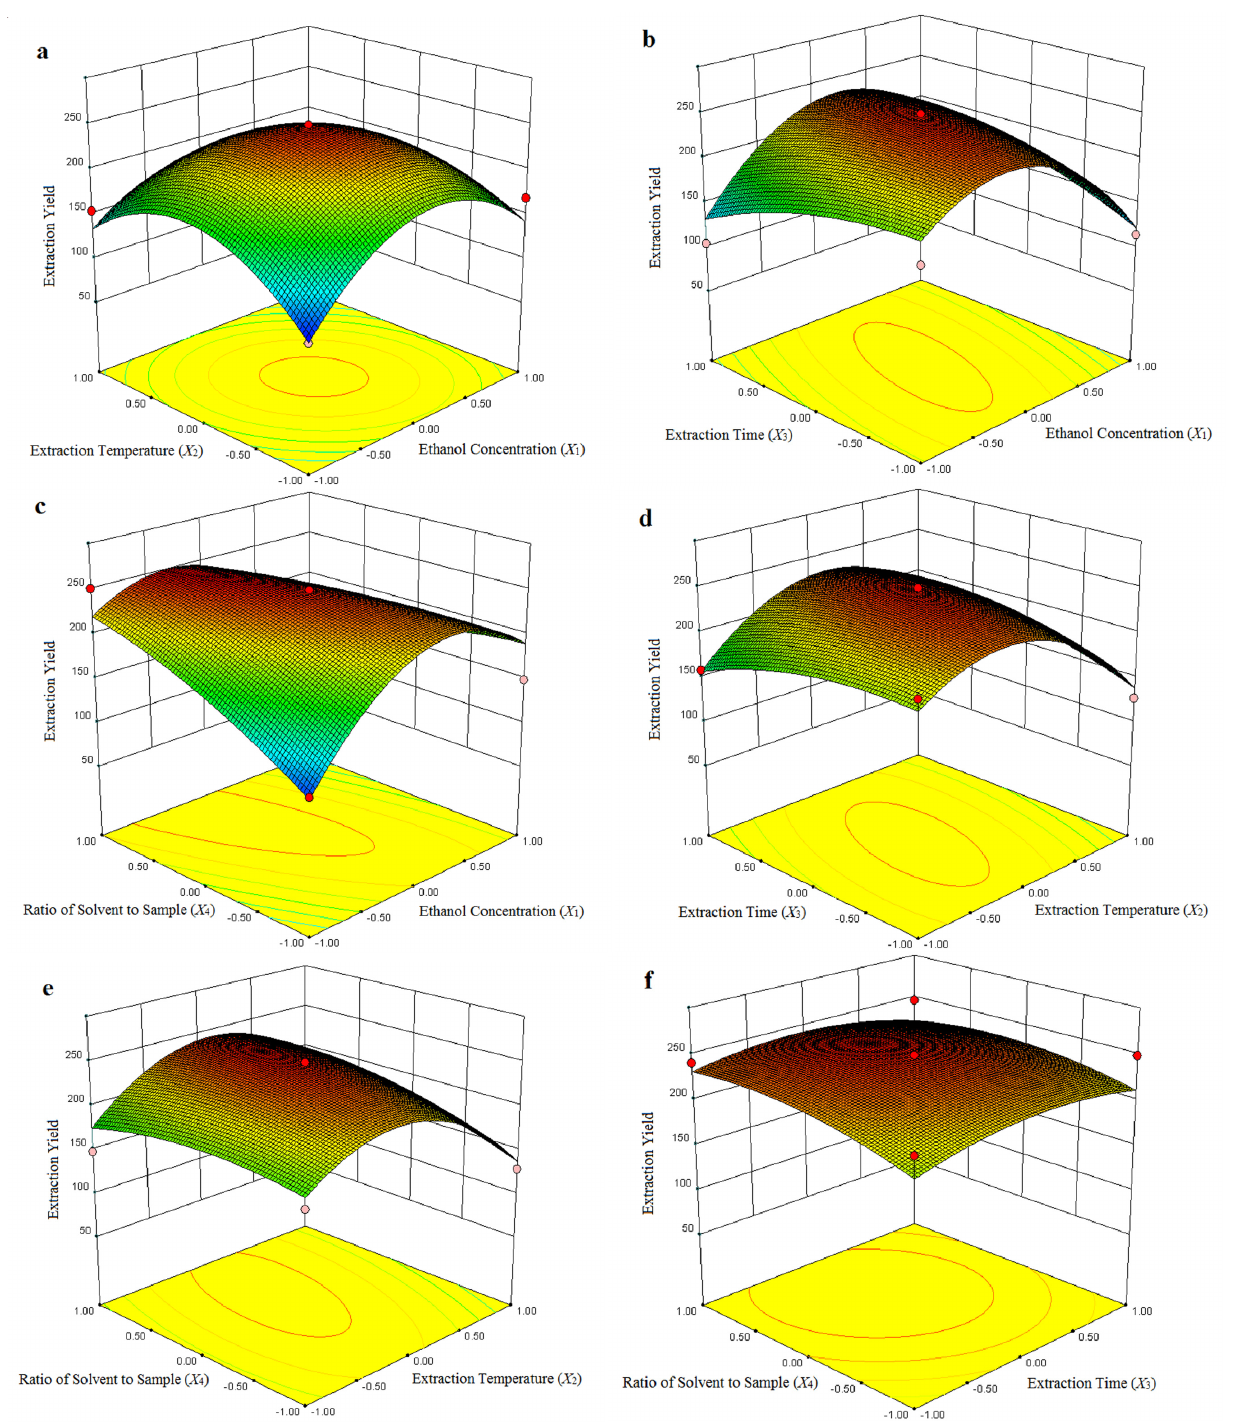
Figure 1. Response surface plots showing the effect of ethanol concentration ( X extraction temperature ( X yield of